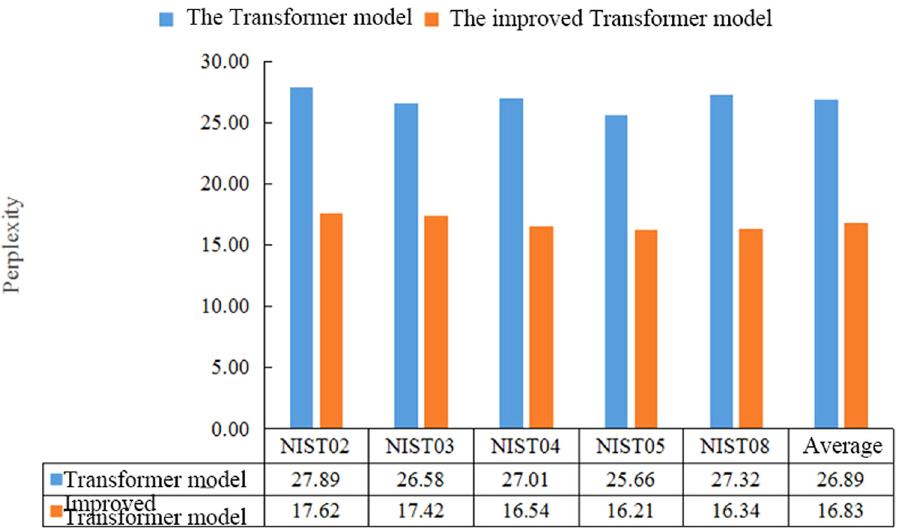
Figure 3: Comparison of perplexity values between di ff erent